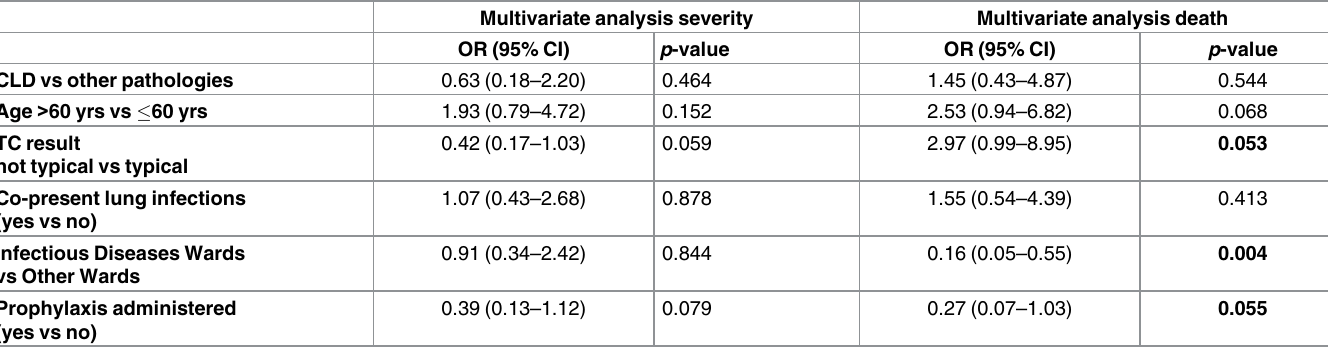
Table 4. Multivariate analysis of predictors of PjP severity and death in 116 patients with